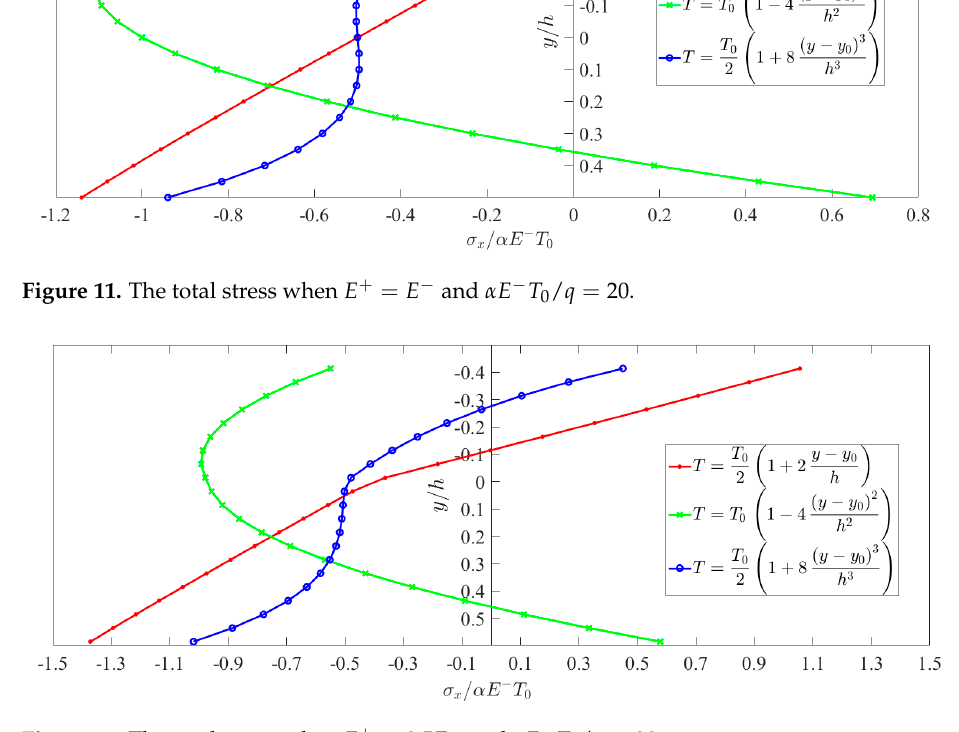
Figure 12. The total stress when E + = 0.5 E − and α E − T 0 / q = 20. Table 2. Dimensionless thermal stresses and amplitude Table 2 lists dimensionless thermal stresses for the linear, square, and cubic rise modes as well as the variations of amplitude value throughout the beam. The computation of amplitude value is, for the linear and cubic relation, from the top to bottom of the beam; and for the square relation, is from the maximum tensile stress to maximum compressive one. It is easy to see from Table 2 that, under the temperature rise mode of square relation, the amplitude is 2.21 for E + − = , versus 1.80 for E E + − = , and decreases to 1.58 for − = E + − = , versus 1.28 for − =